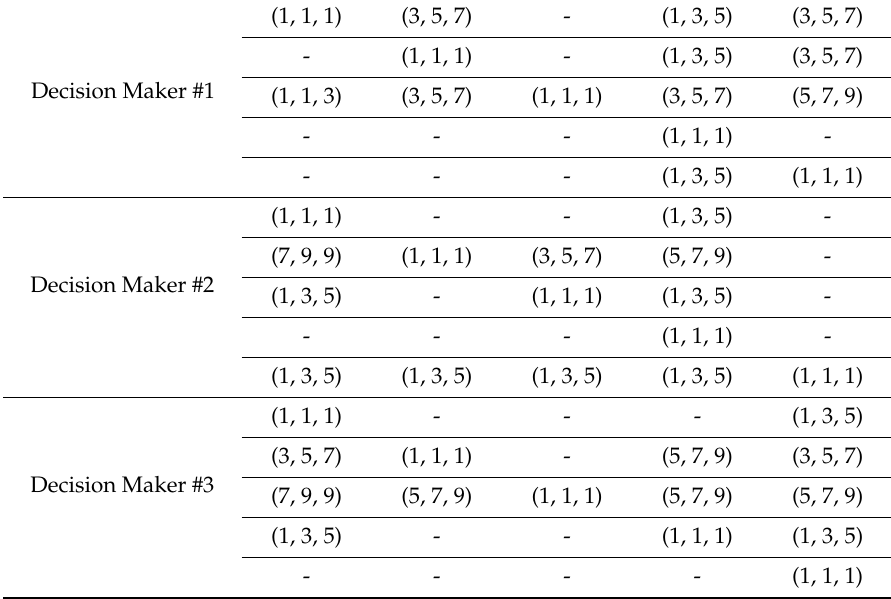
Table 1. Fuzzy pairwise comparison matrixes constructed by three decision makers.